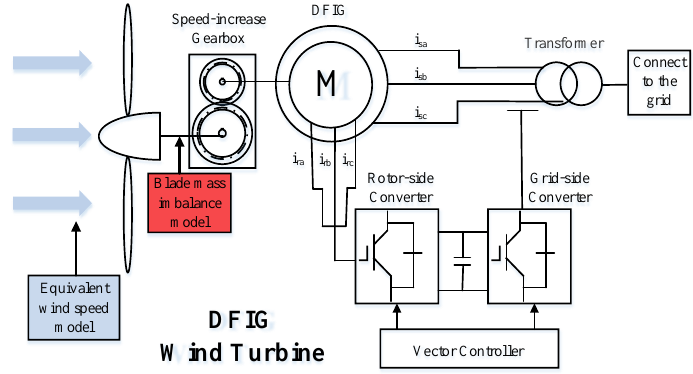
Figure 6. Simulation platform.